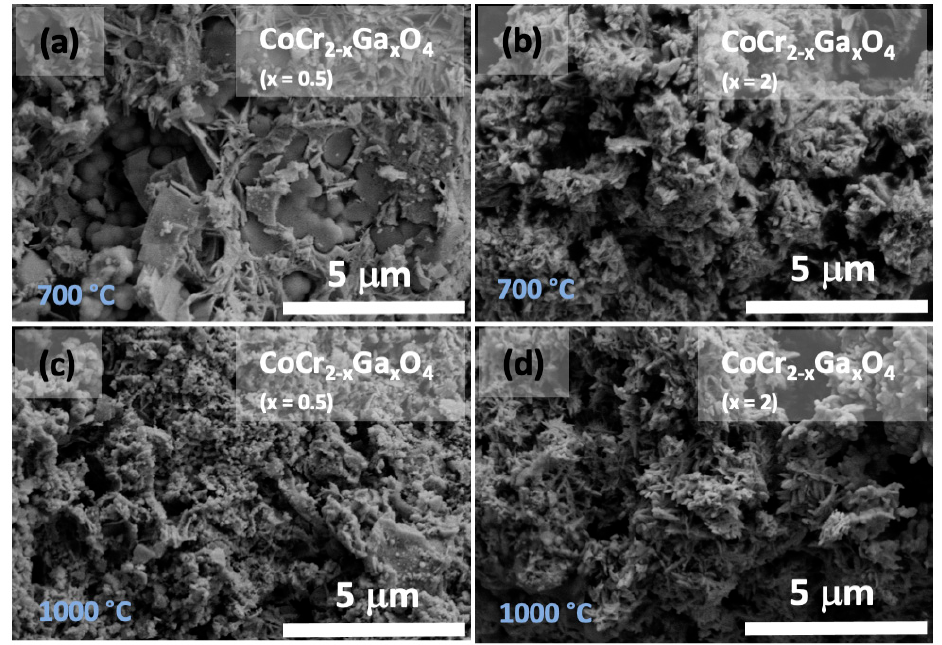
Figure 2. SEM micrographs of sol–gel derived CoCr 2 − x Ga x O 4 pigments, when x = 0.5 ( a , c ) and x = 2 ( b , d ), obtained at 700 °C ( a , b ) and 1000 °C ( c , d ).